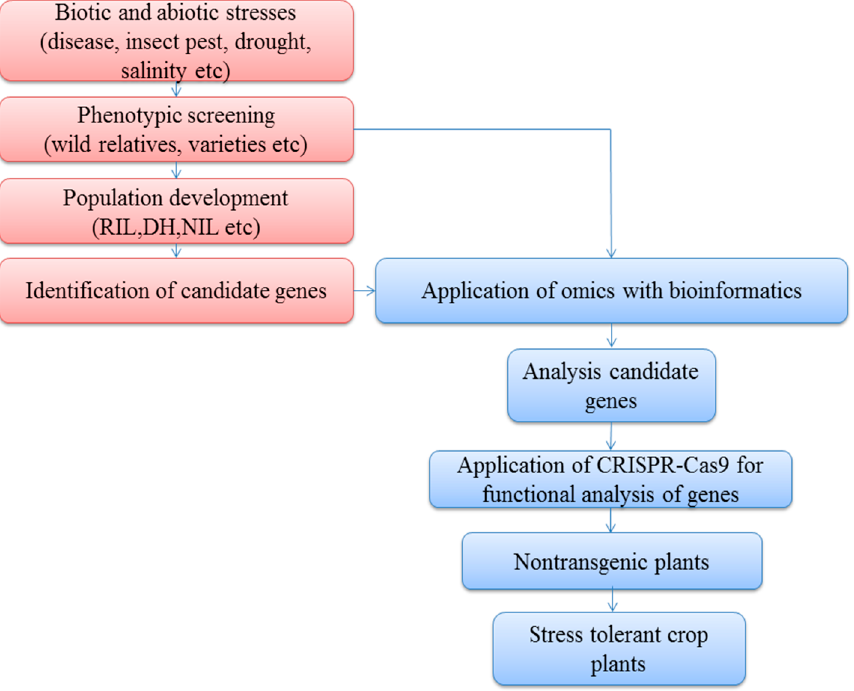
Figure 2. Omics and CRISPR-Cas9 strategies for garnering knowledge on molecular systems and gene function as the main objective for producing stress-tolerant crop plants. RIL: Recombinant inbred line, DH: Doubled haploid, NIL: Near isogenic line.